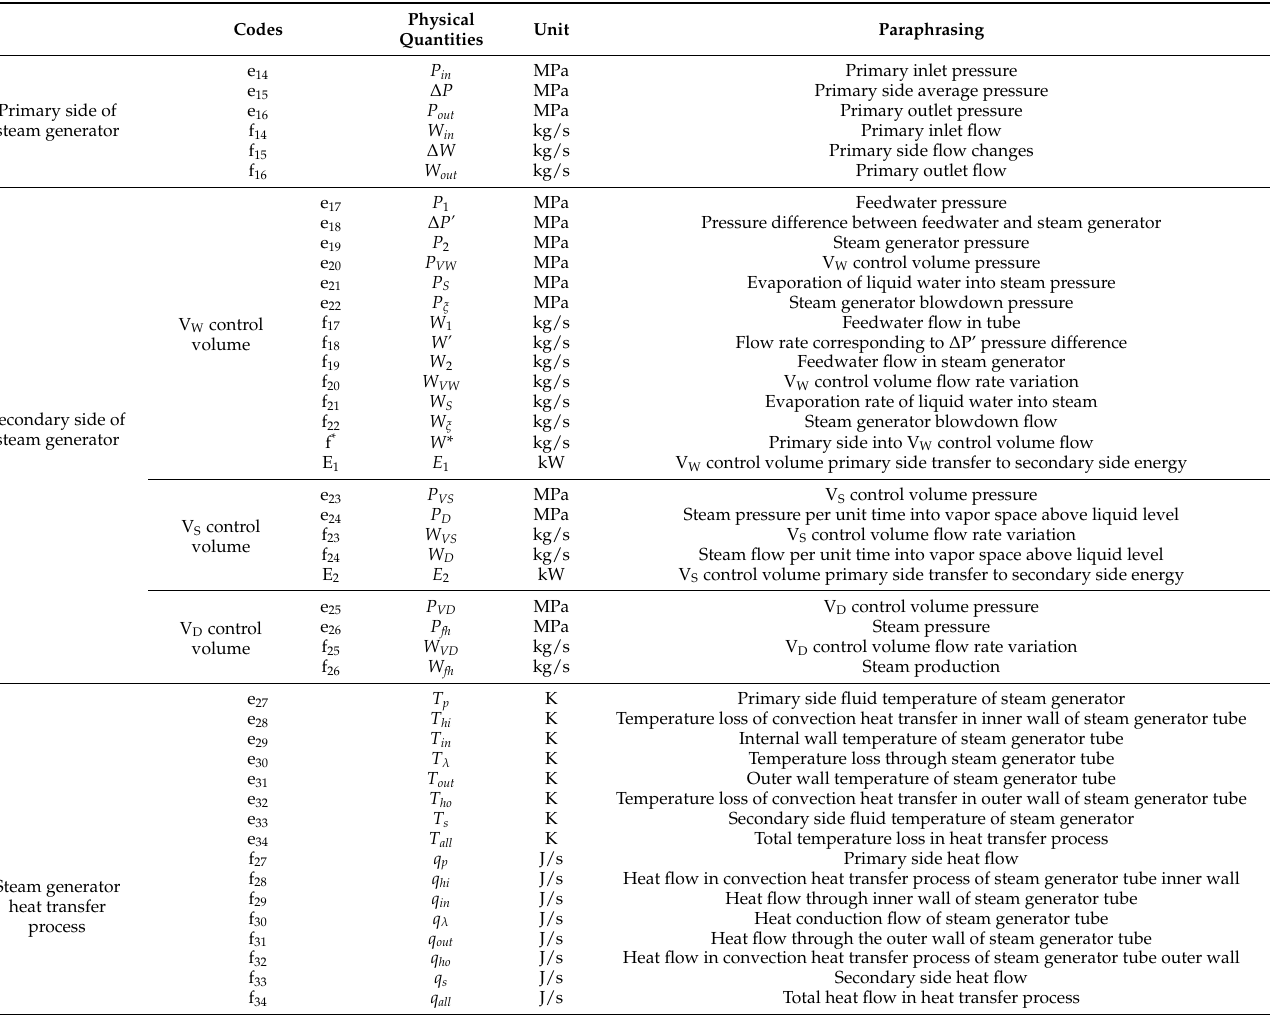
Figure 9. Bond graph model of the heat transfer process of the steam generator. Table 2. The meaning of physical quantities shown in Figures 8 and